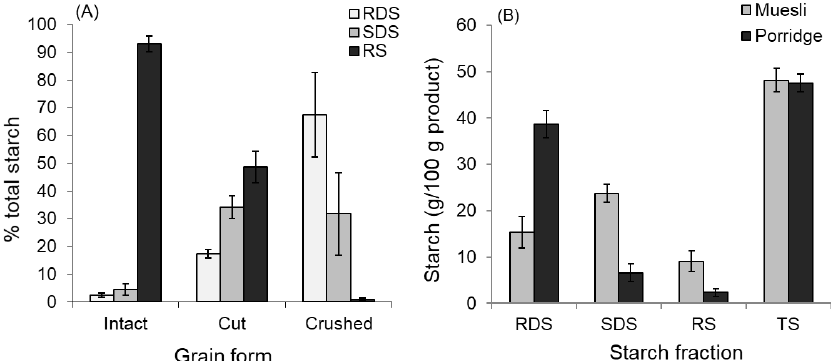
Figure 4. Effects of physical state and cooking on starch fractions in cereals: ( A ) Effect of cutting versus crushing (chewing) of cooked wheat kernels on starch digestion. ( B ) Effect of complete cooking (porridge) versus no cooking (muesli) of a crushed partially cooked (steamed) cereal product (rolled oats). Means ± SD. (RDS = rapidly, SDS = slowly, RS = resistant and TS = total starch).